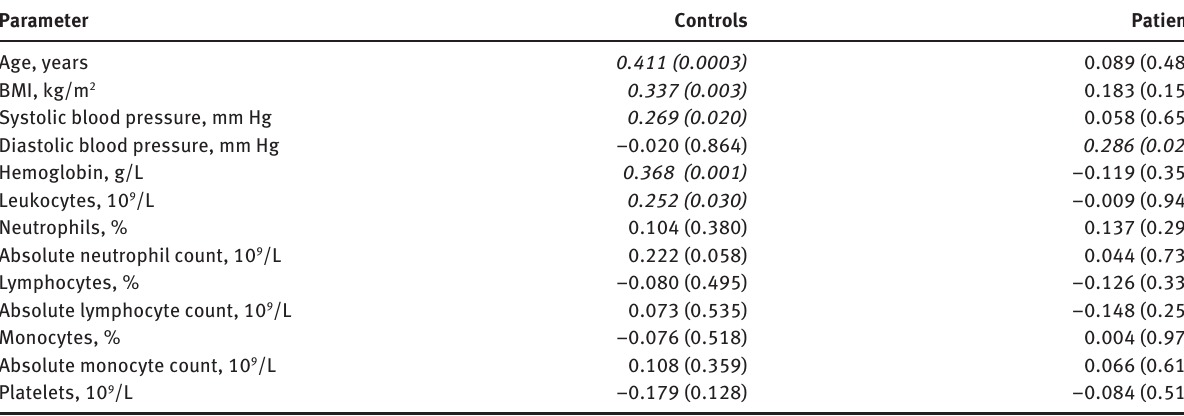
Table 4 Correlations of ferritin with investigated parameters.